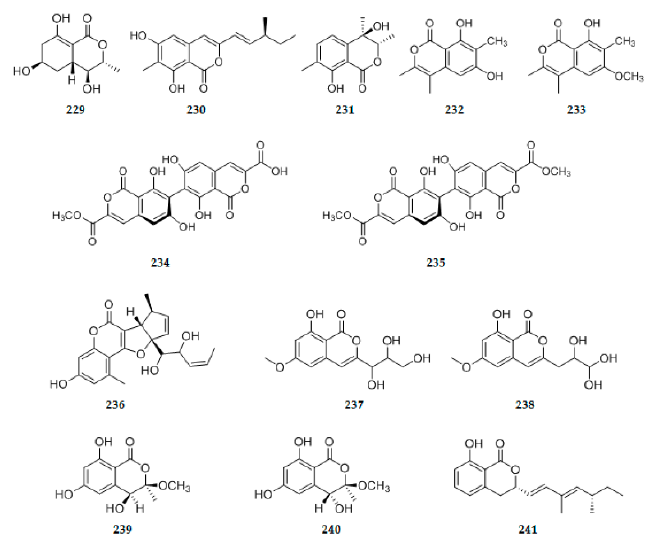
Figure 8. Chemical structures of penylpropanoids and their derivatives.